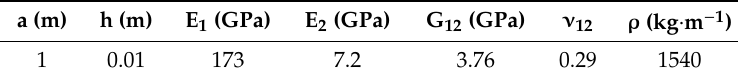
Table 4. Geometric and material characteristics of the